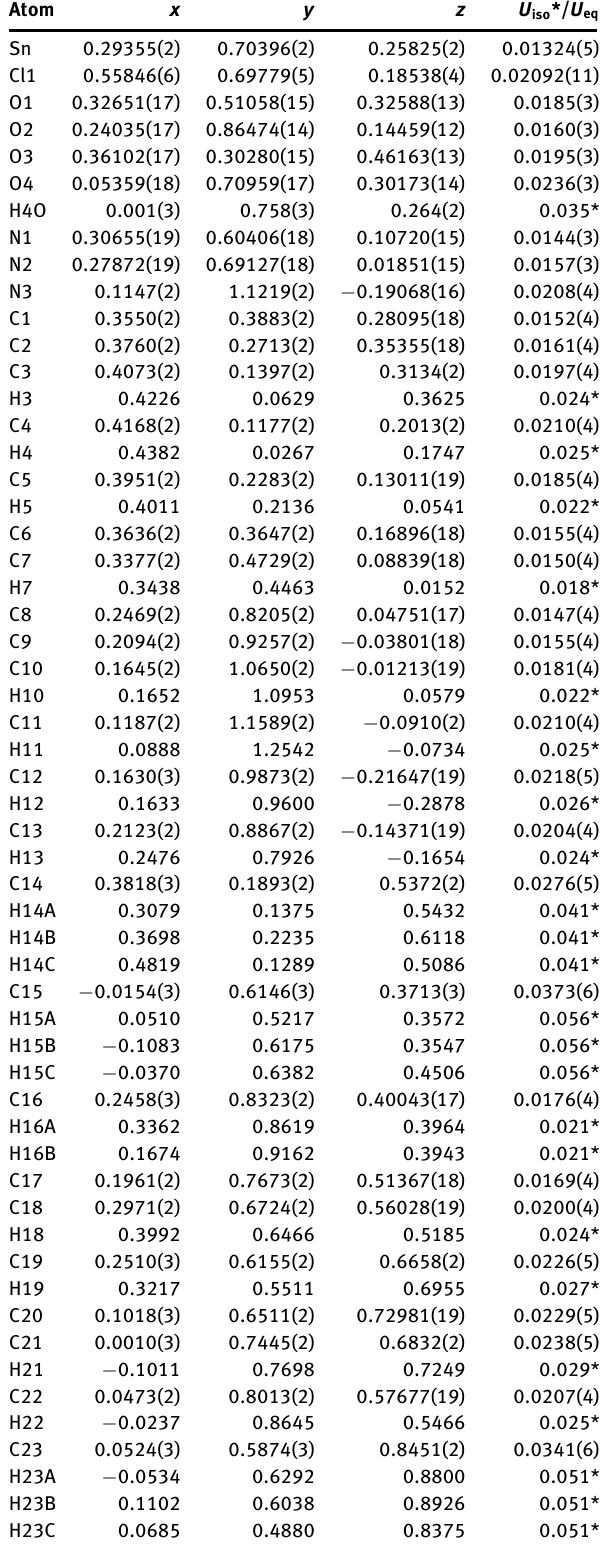
Table 2: Fractional atomic coordinates and isotropic or equivalent isotropic displacement parameters (Å 2